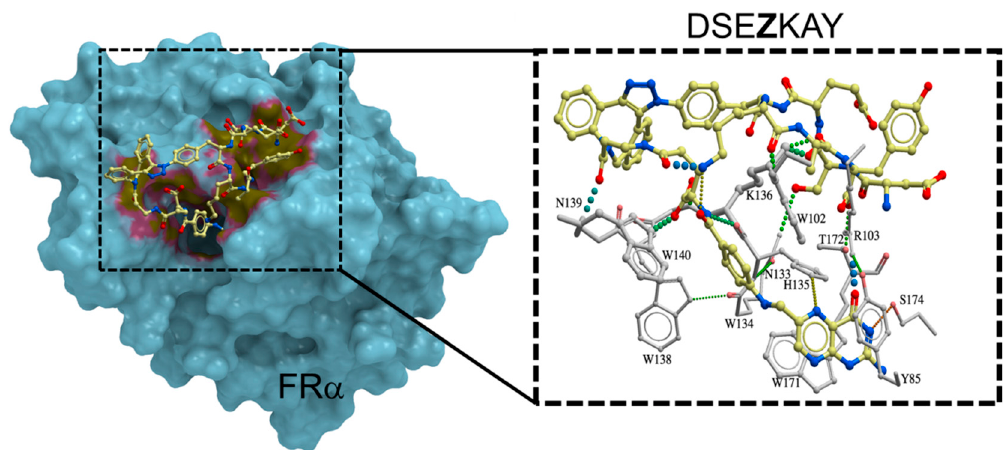
Figure 5. Docking model of DSE Z KAY (yellow) with the surface of the FR α (blue). The gradation of yellow and magenta colors on the surface of the FR α indicated the interaction between the ligand and surface of the FR α . This figure was prepared by the program ICM-Pro. The left dotted box area of interaction between DSE Z KAY with FR α is zoomed in right dotted box. All the dotted lines in right dotted box indicate an “increased” interaction of DSE Z KAY with the FR α (except for the interaction of folate with the FR α ).